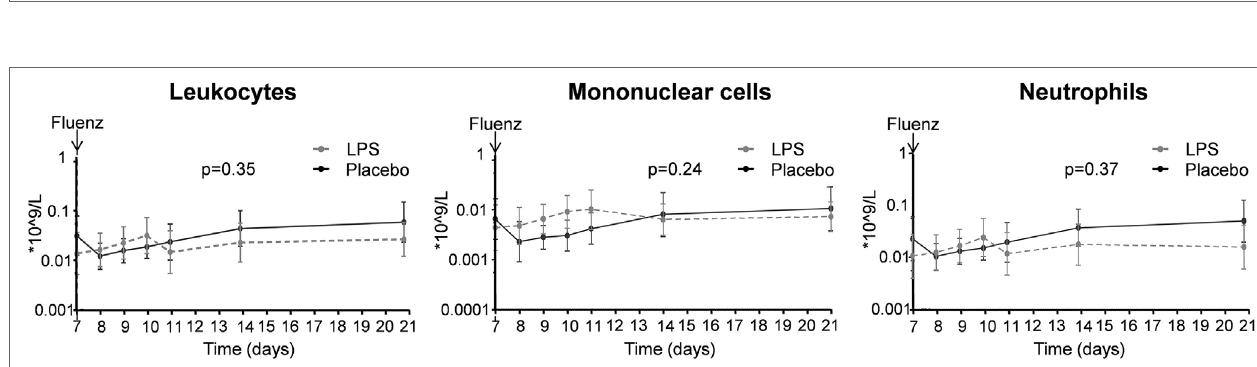
FigUre 10 | Cytokines in nasal wash in the 26 subjects who were challenged with lipopolysaccharide (LPS) ( n = 13) or placebo ( n = 13) on day 0 and displayed infectivity after inoculation with Fluenz on day 7. Data are represented as geometric mean with 95% CI.